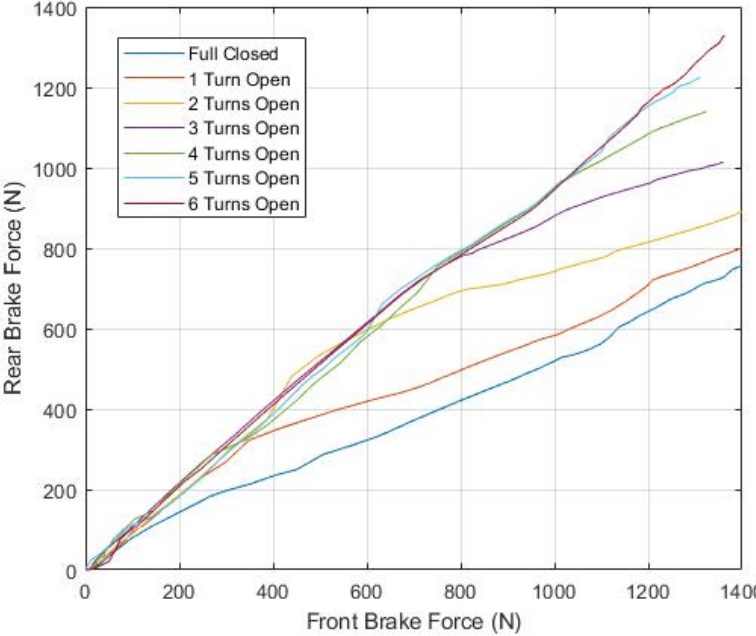
Figure 9. Raw test result data of front and rear brake force for lever application only with varying levels of proportioning.